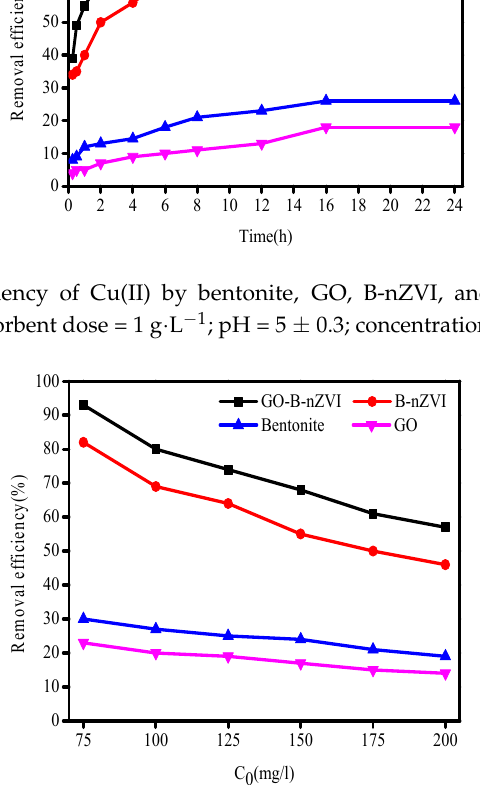
Figure 7. Removal efficiency of Cu(II) by bentonite, GO, B-nZVI, and GO-B-nZVI with concentration of Cu(II) (Temperature = 18 ◦ C; adsorbent dose = 1 g · L − 1 ; pH = 5 ± 0.3; adsorption time = 12 h).